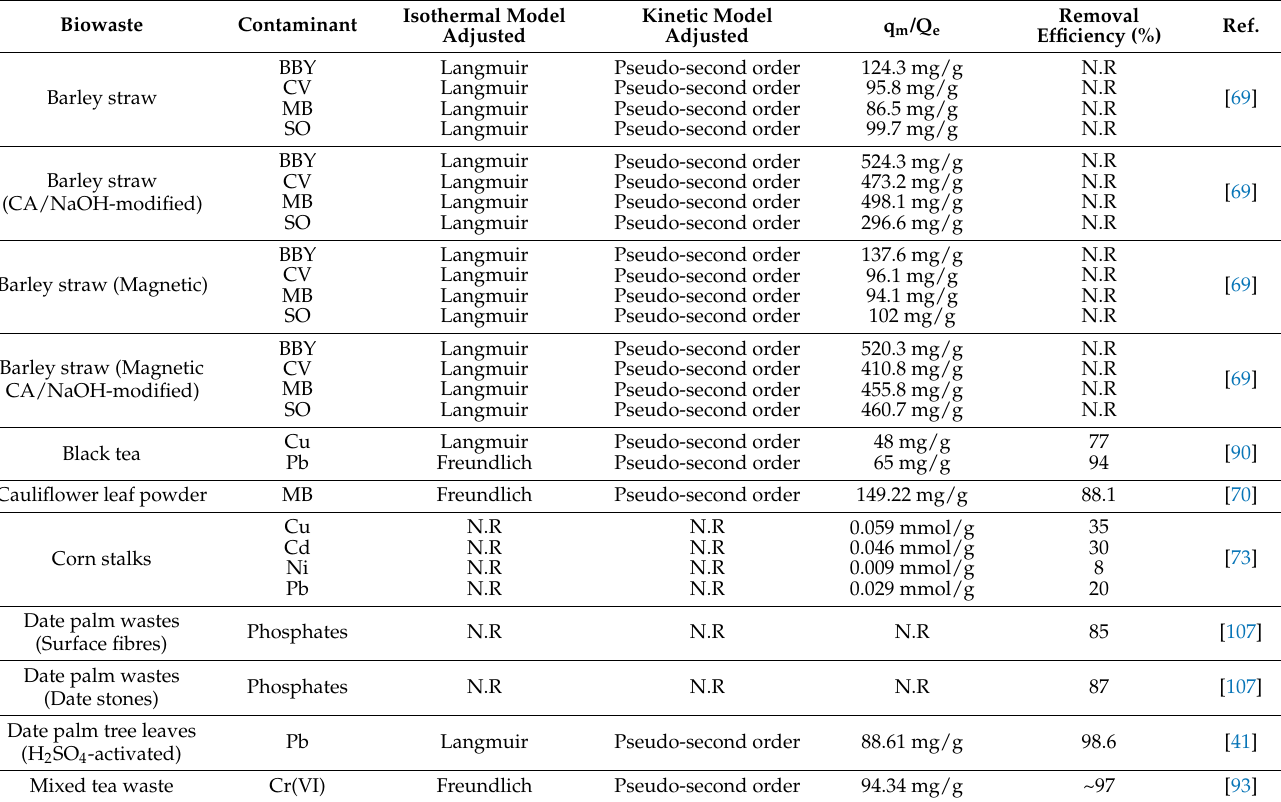
Table 5. Adsorption parameters and removal efficiencies of different biosorbents derived from herbage and forage for the removal of pollutants in aqueous